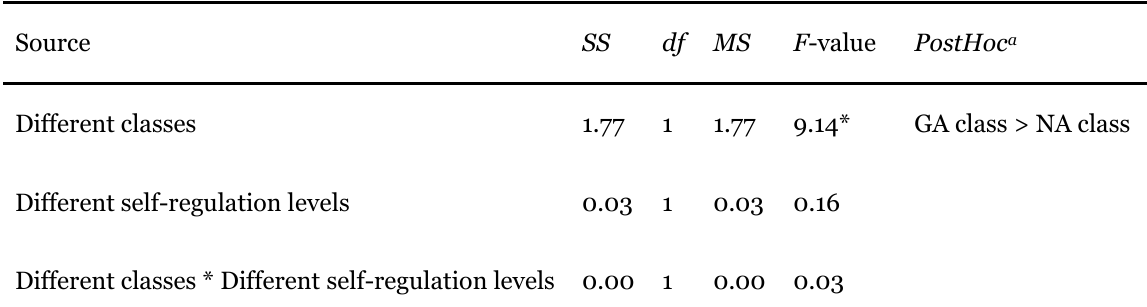
Two-Way ANOVA of Responding Rate (n=79)